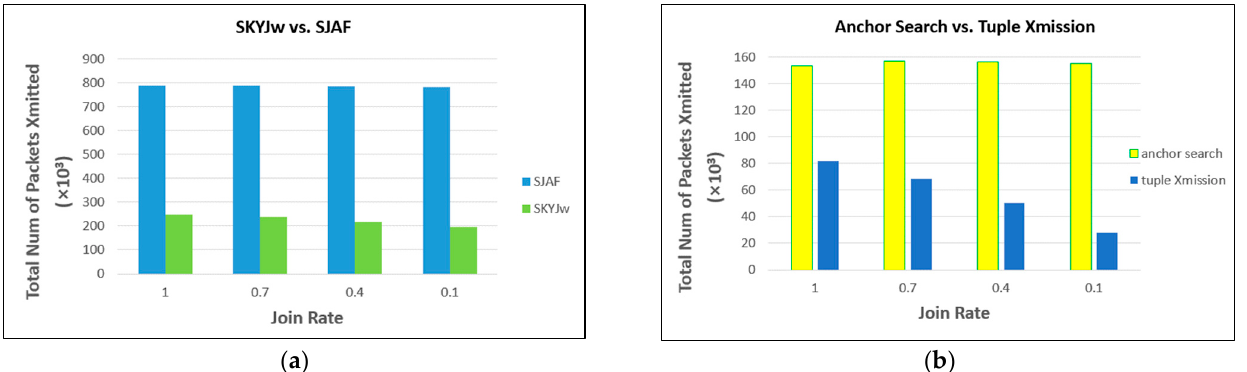
Figure 14. ( a ) Comparison between SKYJw and SJAF as the join rate varies from 1.0 to 0.1. ( b )